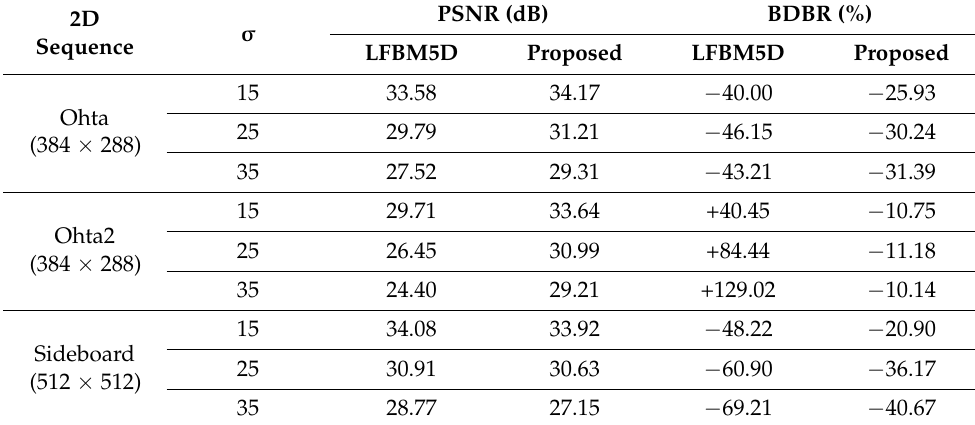
Table 3. Comparison of performance for noisy 2D multi-views.